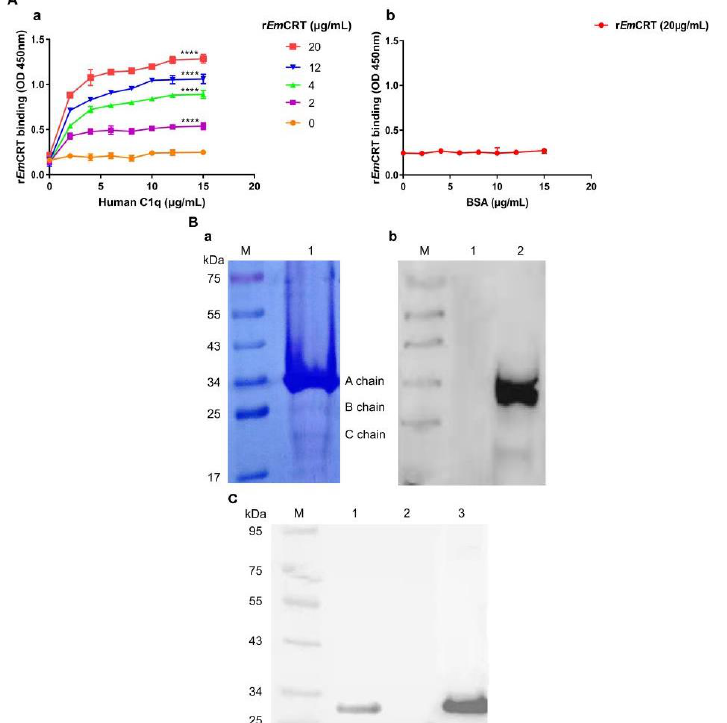
Figure 1. Recombinant Em CRT bound to human C1q. ( A ) r Em CRT (0, 2, 4, 12, 20 μg /mL) in binding